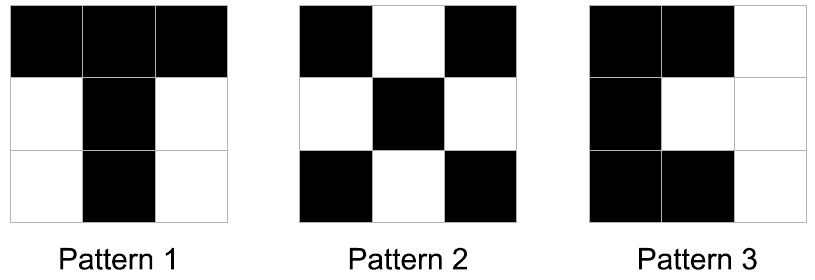
Figure 9. Set of patterns used for SNN training.